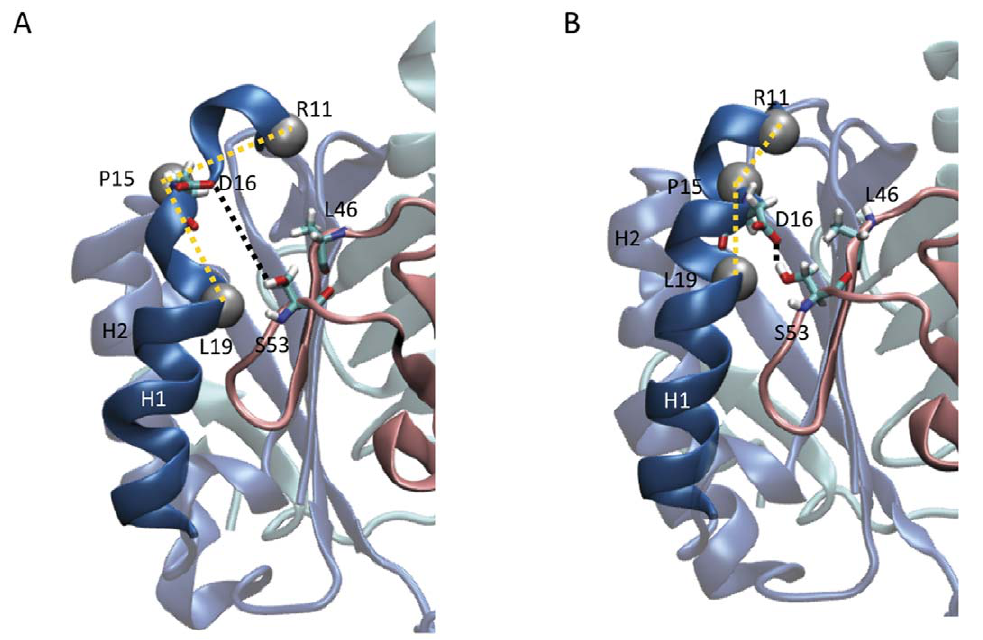
Figure 6. a -helix H1 fluctuates between two states as observed during MD simulation. (A, B) Snapshots of the protein where the angle between the C a atoms of residues Leu19 C a :Pro15 C a :Arg11 C a is , 90 u (shortened a -helix H1) and , 120 u (extended a -helix H1),